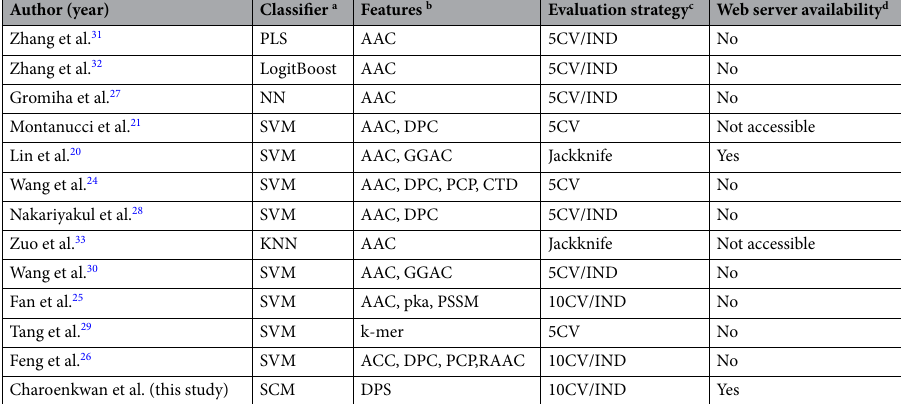
Table 1. Summary of existing ML-based models for thermophilic protein prediction. a KNN k-nearest neighbor, NN neural networks, PLS partial least-square regression, SVM support vector machine. b AAC amino acid composition, CTD composition-transition-distribution, DPC dipeptide composition, DPS dipeptide propensity scores, GGAP g-gap dipeptide composition, k-mer fragment-based technique, pka acid dissociation constant, PCP physicochemical properties, PseACC pseudo amino acid composition, PSSM position specific scoring matrix, RACC reduce amino acid composition, TC tripeptide composition. c 5CV fivefold cross- validation, 10CV tenfold cross-validation, jackknif jackknife cross-validation, IND independent test. d